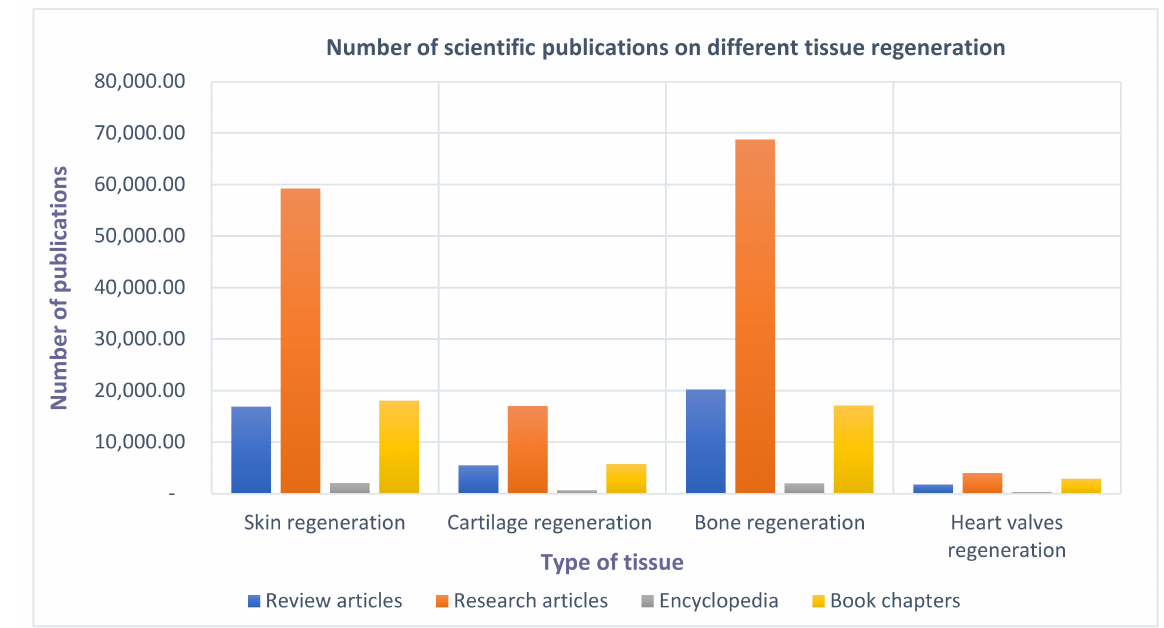
Figure 1. Number of scientific publications on different tissue regeneration (search done through Science Direct on 1 May